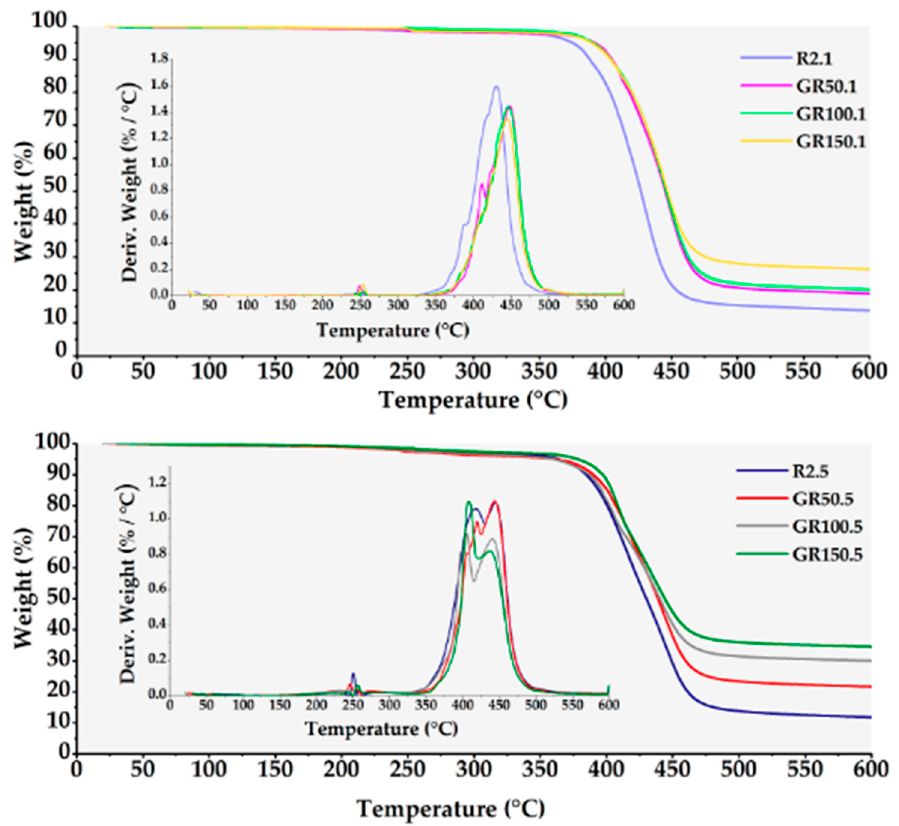
Figure 9. TGA and DTG curves of reference and graphene-coated fabrics for 0.1 and 0.5 mm coating thicknesses.